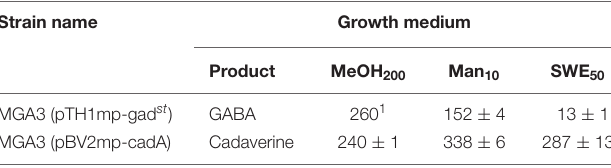
TABLE 4 | Production levels (mg/L) of GABA and cadaverine by recombinant B. methanolicus MGA3 strains cultivated in Man 10 , SWE 50 , and MeOH 200 media.